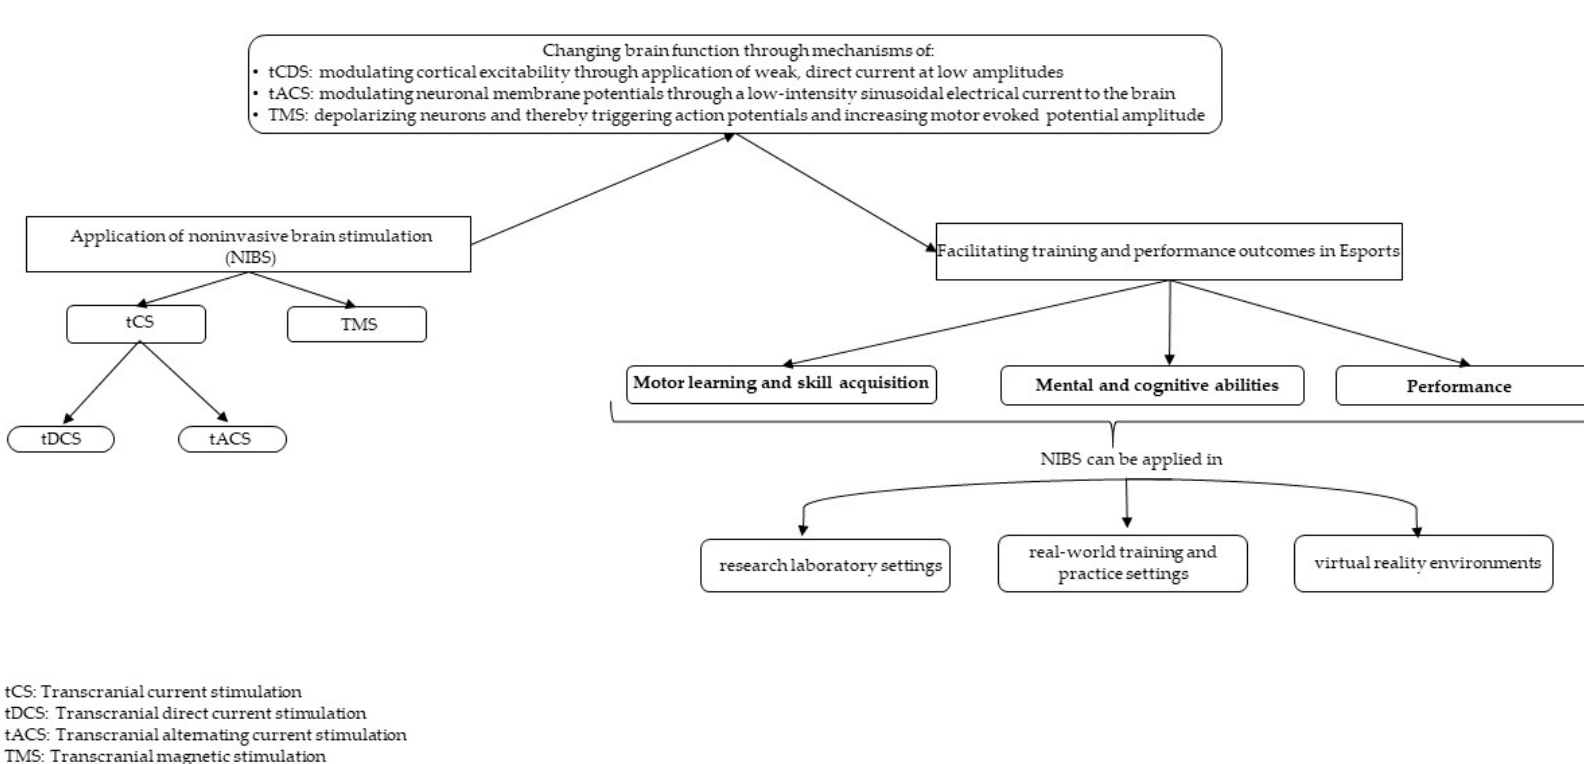
Figure 1. A framework for potential research on non-invasive brain stimulation in esports.